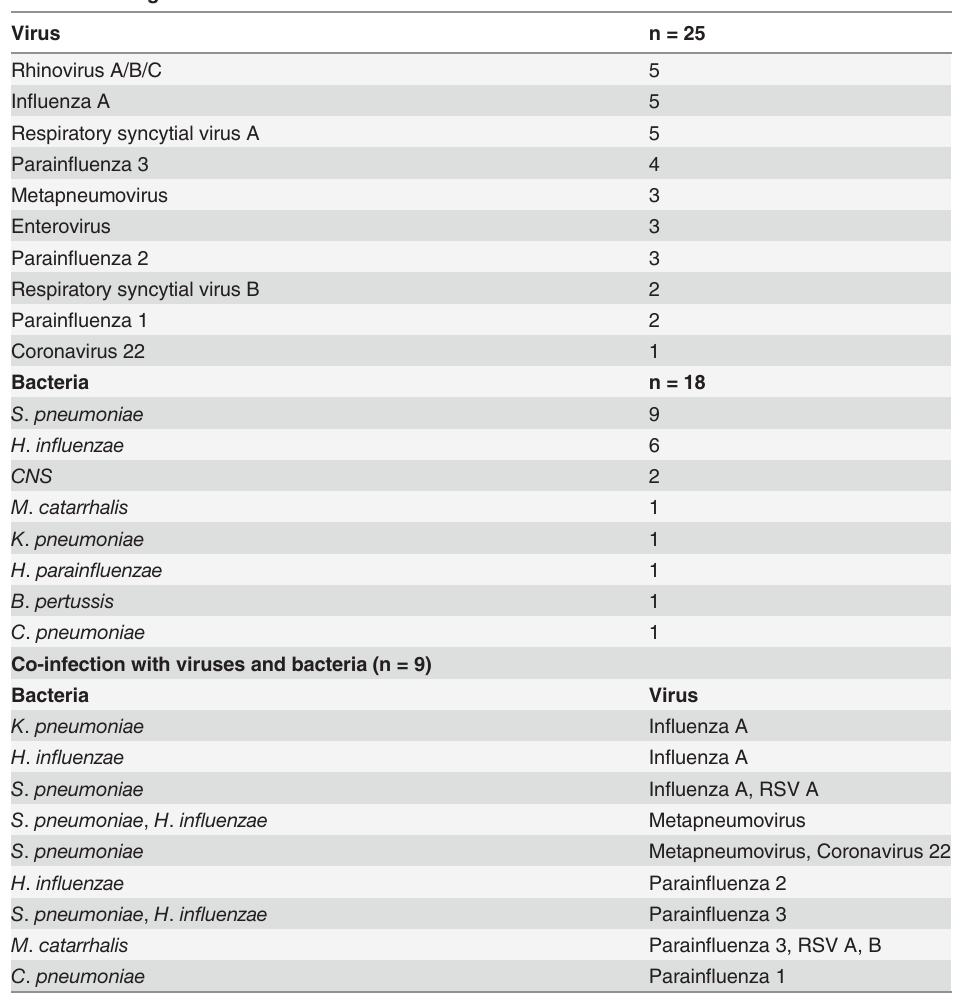
Table 2. Pathogens